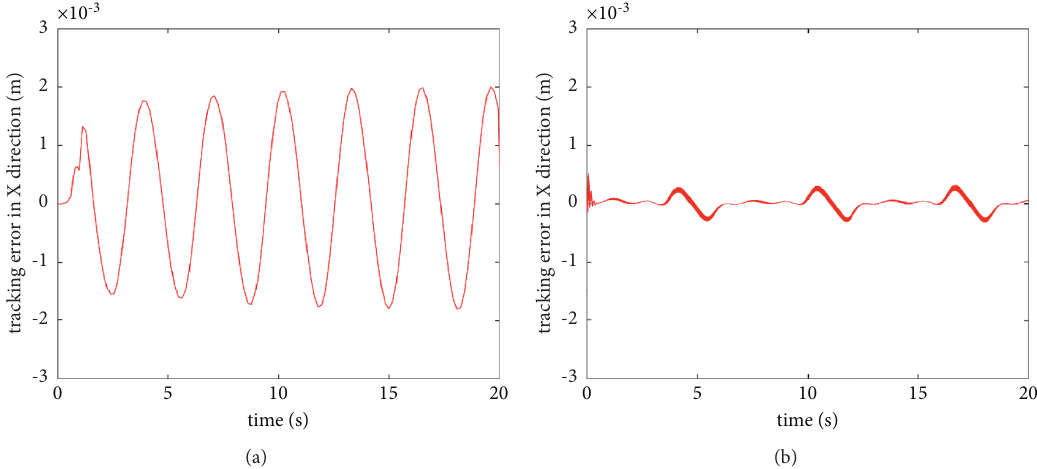
Figure 7: The trajectory tracking error of work platform in x direction under the action of (a) backstepping control and (b) NN-based backstepping control.